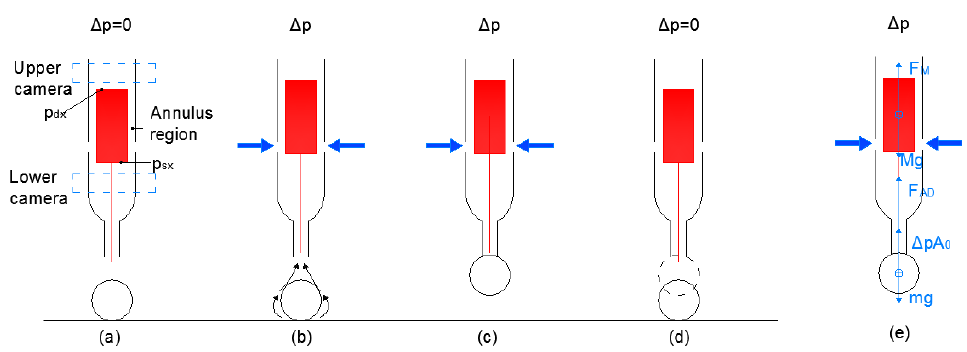
Figure 3. Off ( a ), grasping ( b ), handling ( c ) and releasing ( d ) manipulation phases of the studied vacuum microgripper. Forces acting on the grasped object and the releasing mass during the handling phase ( e